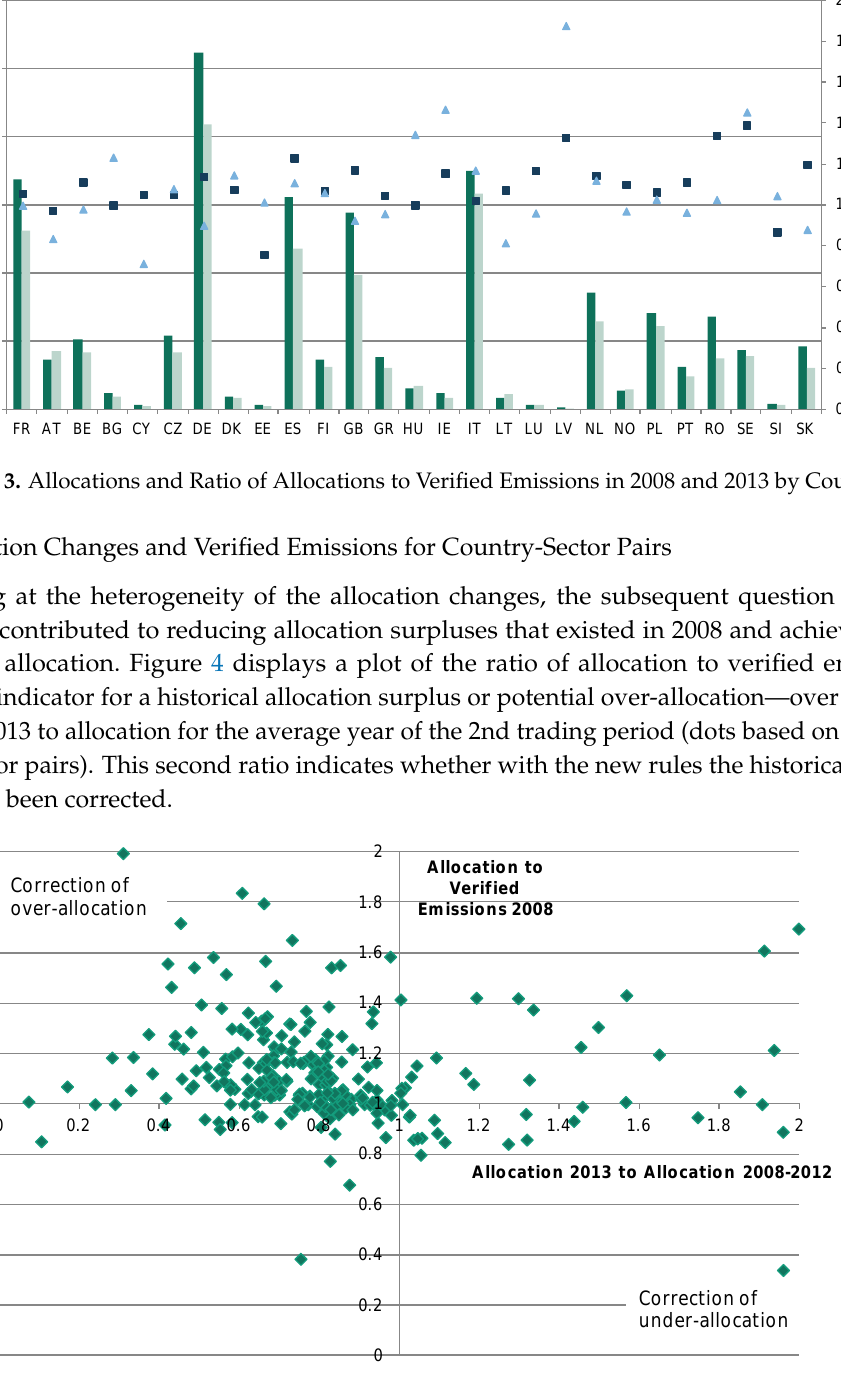
Figure 4. Scatterplot of Allocation to Verified Emissions Ratio 2008 over Ratio of Allocation 2013 to Average Allocation 2008–2012 (based on median values for country sector pairs). Each data point represents a country-sector pair. Note: x -axis truncated at 2 which hides 14 data points mostly from the chemical sector (17.12: EE. 20.11: CZ, SE, 20.15: FI, HU, LT, SK, GB, IT, PT, AT, 20.16: AT, HU, SE).